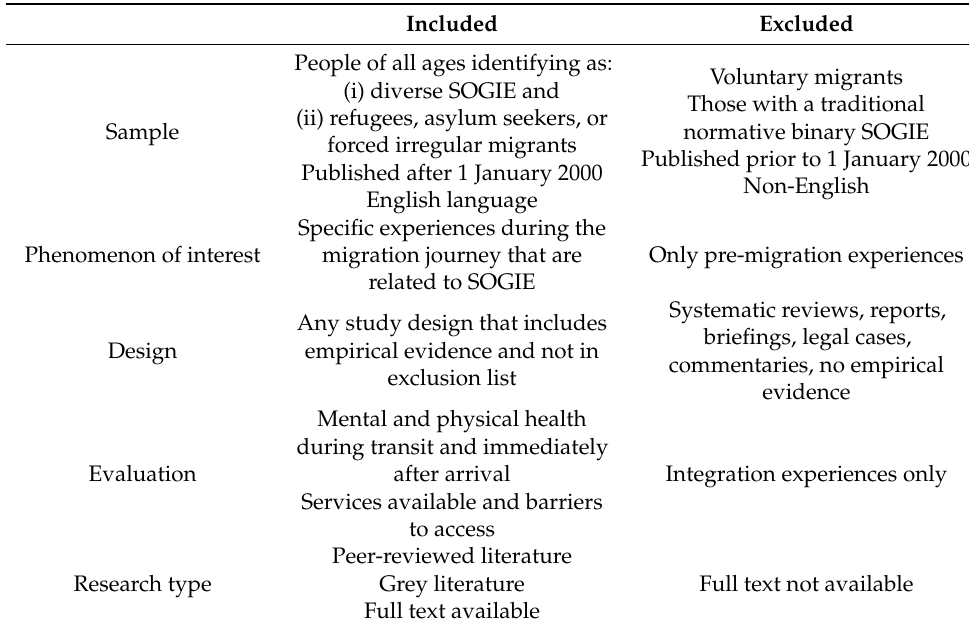
Table 1. Inclusion and exclusion